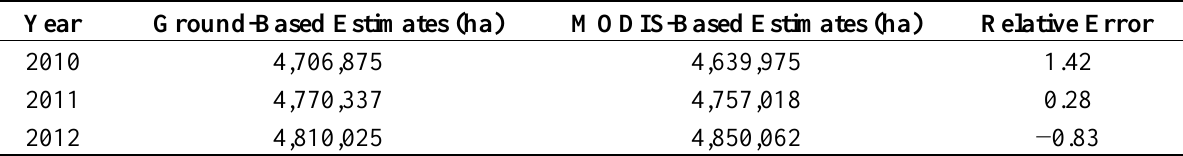
Table 3. Application of the optimal value of the multiplier illustrated in Equations (5) and (6) during 2010–2012; and comparison between MODIS and ground-based estimates boro rice cultivation area at the country level.